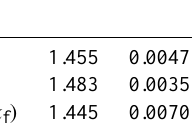
Figure 1 (M. R. Perrone et al.) 6